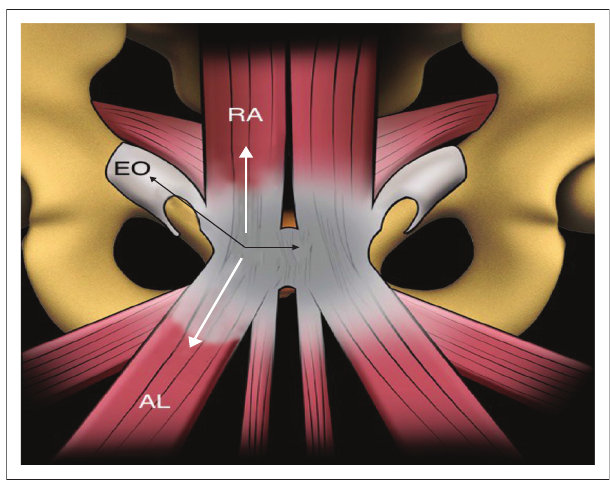
FIGURE 3: Vector and shearing forces across the prepubic aponeurotic complex (P-PAC). White arrows: vector forces; black arrows: shearing forces.